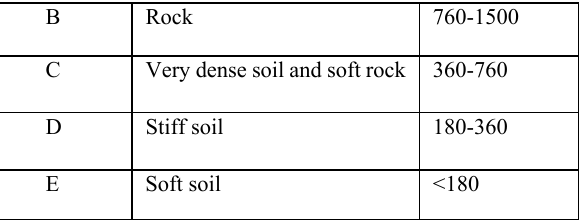
Table1. NEHRP site classes (Wald et al., 2007)